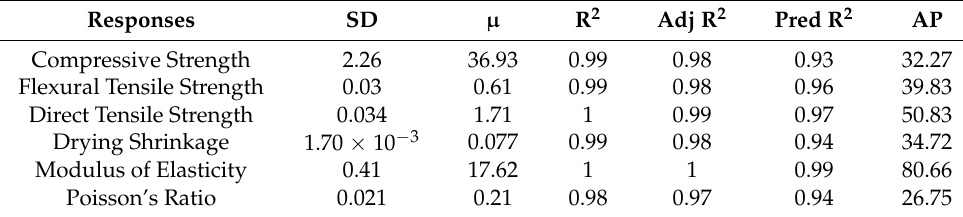
Table 9. Model validation for developed response